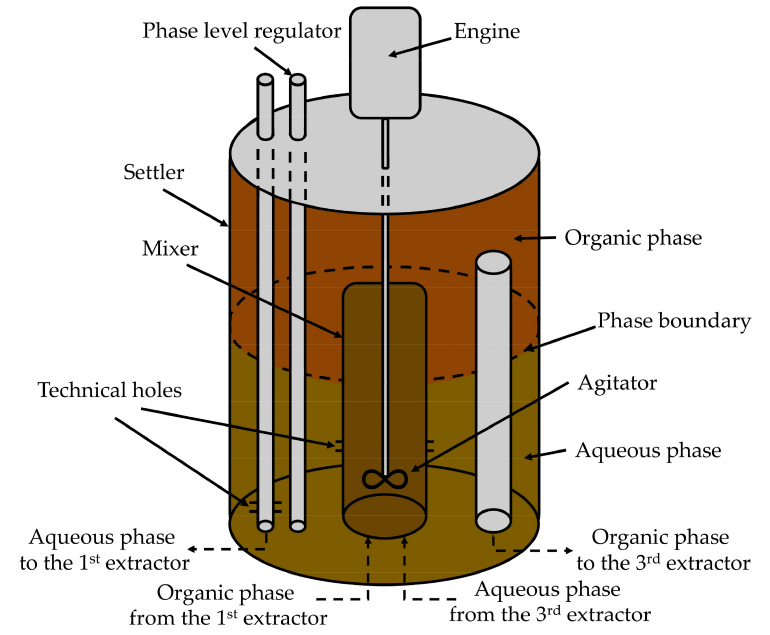
Figure 1. Scheme of mixer-settler extractor at the second stage of iron(III)